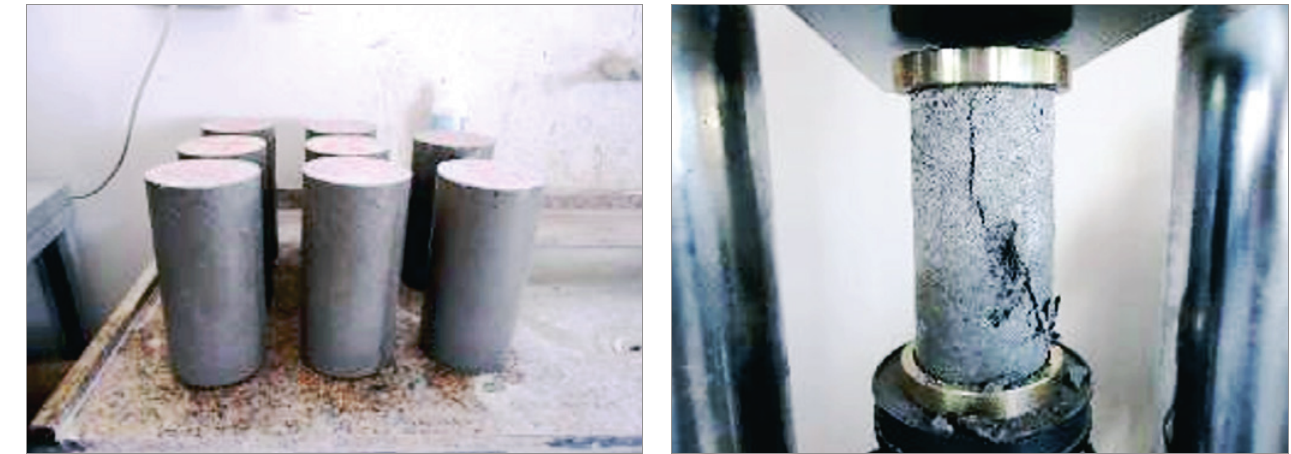
Ilustração dos ensaios dos corpos-de-prova cilíndricos de